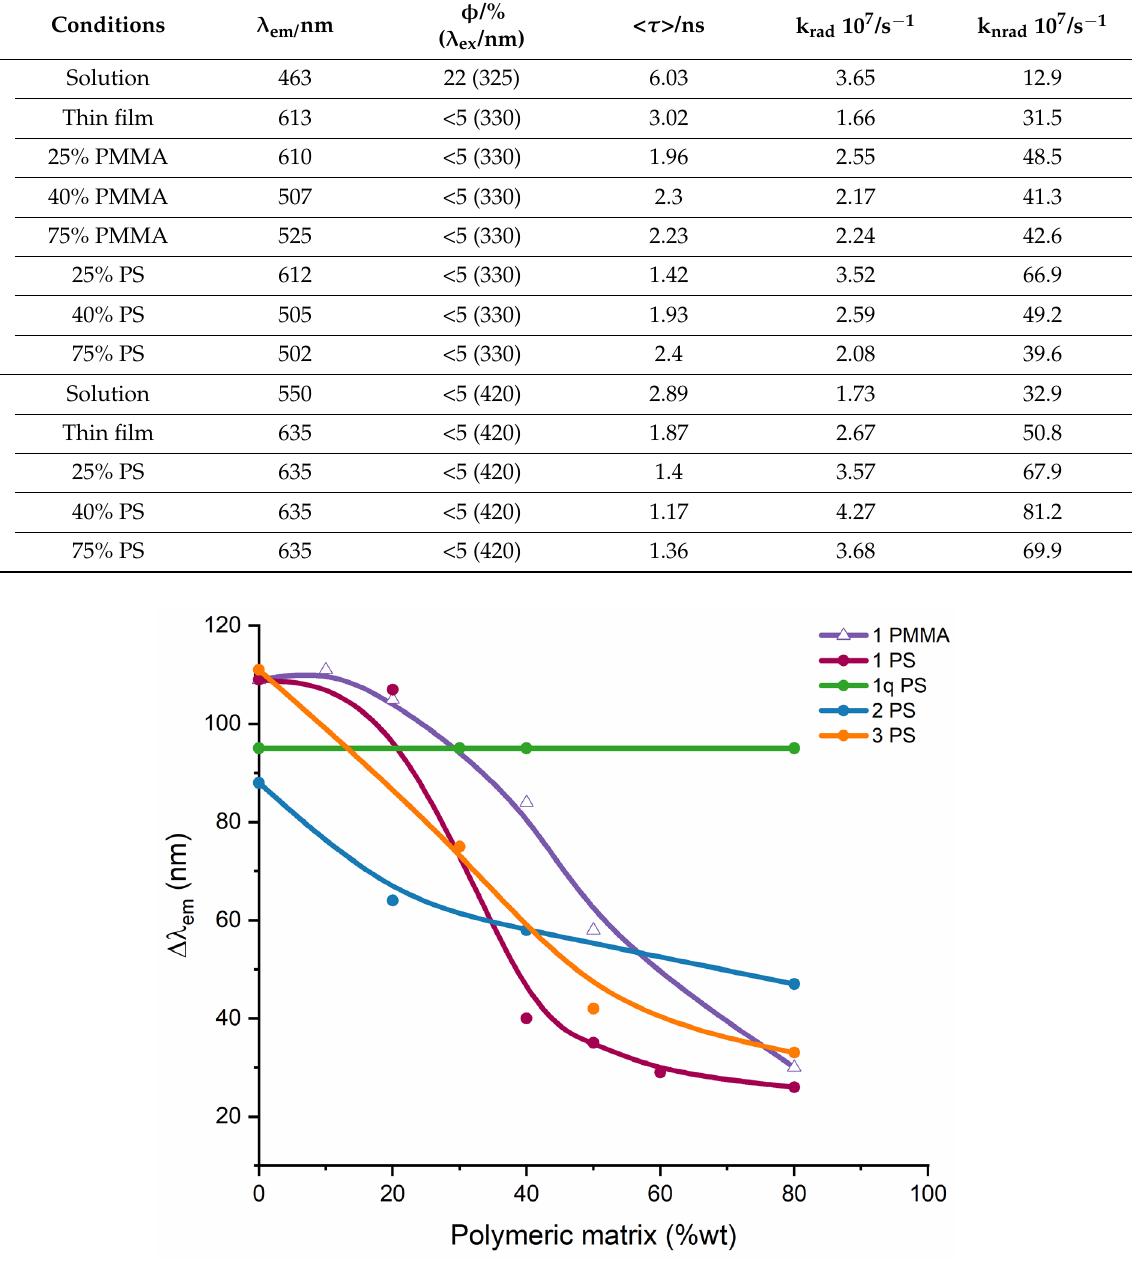
Figure 5. Difference of the emission maximum in thin film and the one in solution ( ∆ λ em ) vs. %wt of Figure 5 . Difference of the emission maximum in thin film and the one in solution ( Δλ em ) vs. %wt polymeric matrix. See of polymeric matrix. See legend.